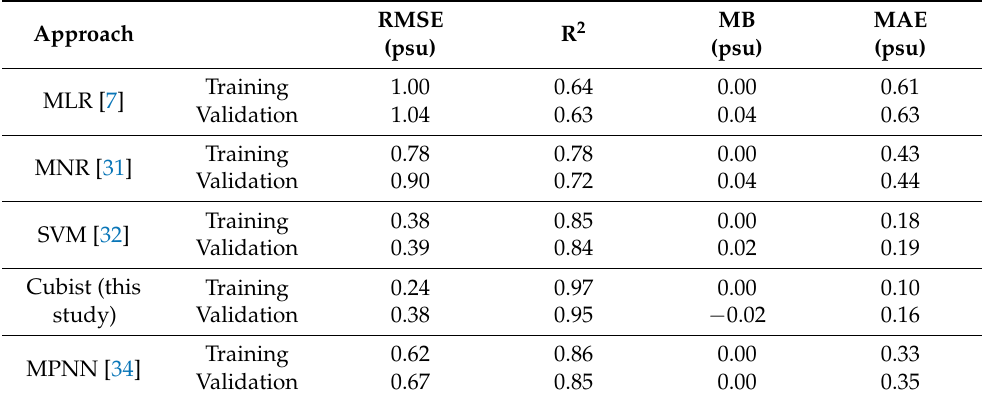
Table 2. Comparison table of SSS estimation approaches in the GOM, all methods used the same training dataset and validation